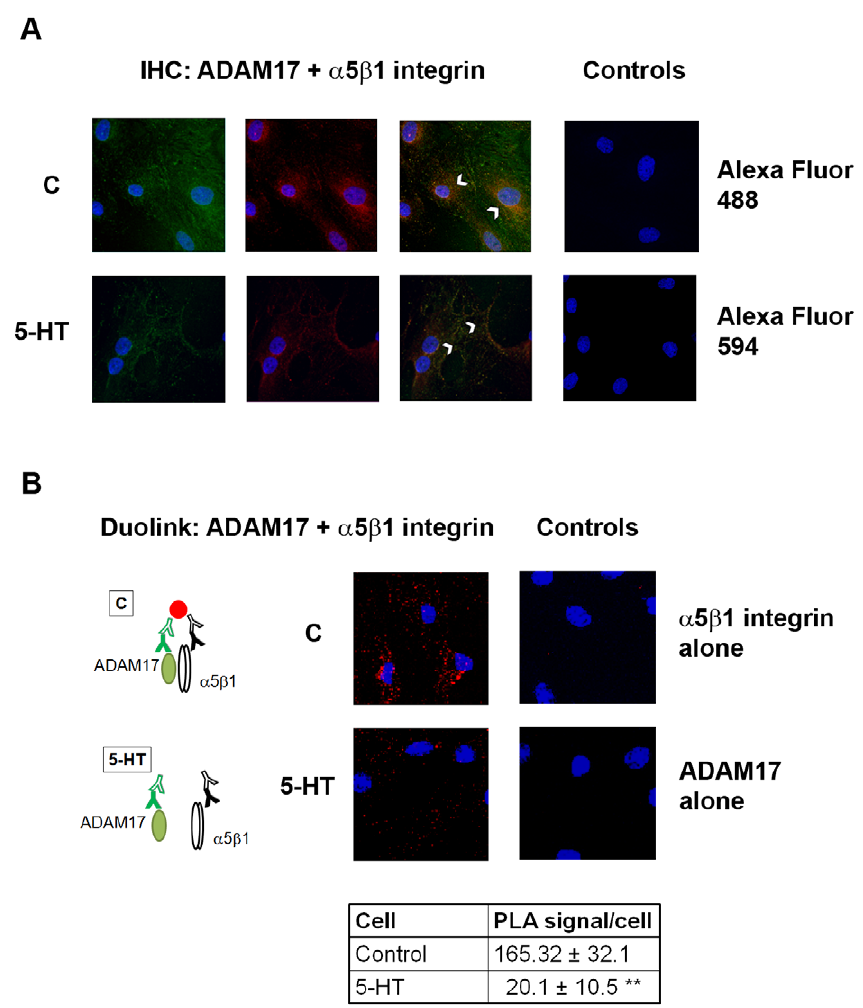
Figure 2. Co-localization of ADAM17 and a 5 b 1 integrin in rat mesangial cells. Control (C) and 1 m M 5-HT -stimulated mesangial cell were fixed, permeabilized, and (A) co-immunostained using ADAM17 antibody (green) and b 1 integrin antibody (red) as indicated in ‘‘Material and Methods’’. Arrows indicate co-localization of ADAM17 and a 5 b 1 integrin immunopositive areas (yellow). For the negative controls we omitted the primary antibodies and used PBS followed by secondary antibodies. (B) Parallel samples were incubated with oligonucleotide-labeled PLA probes after incubation with primary antibodies. PLA signals as fluorescence dots were imaged and quantified. As negative control we used either ADAM17 or a 5 b 1 integrin antibody alone followed by the oligonucleotide-labeled PLA probes. Cartoon explains binding of the fluorescence detection reagent only to antibodies in close proximity; **p , 0.01. Representative examples out of three experiments are shown.